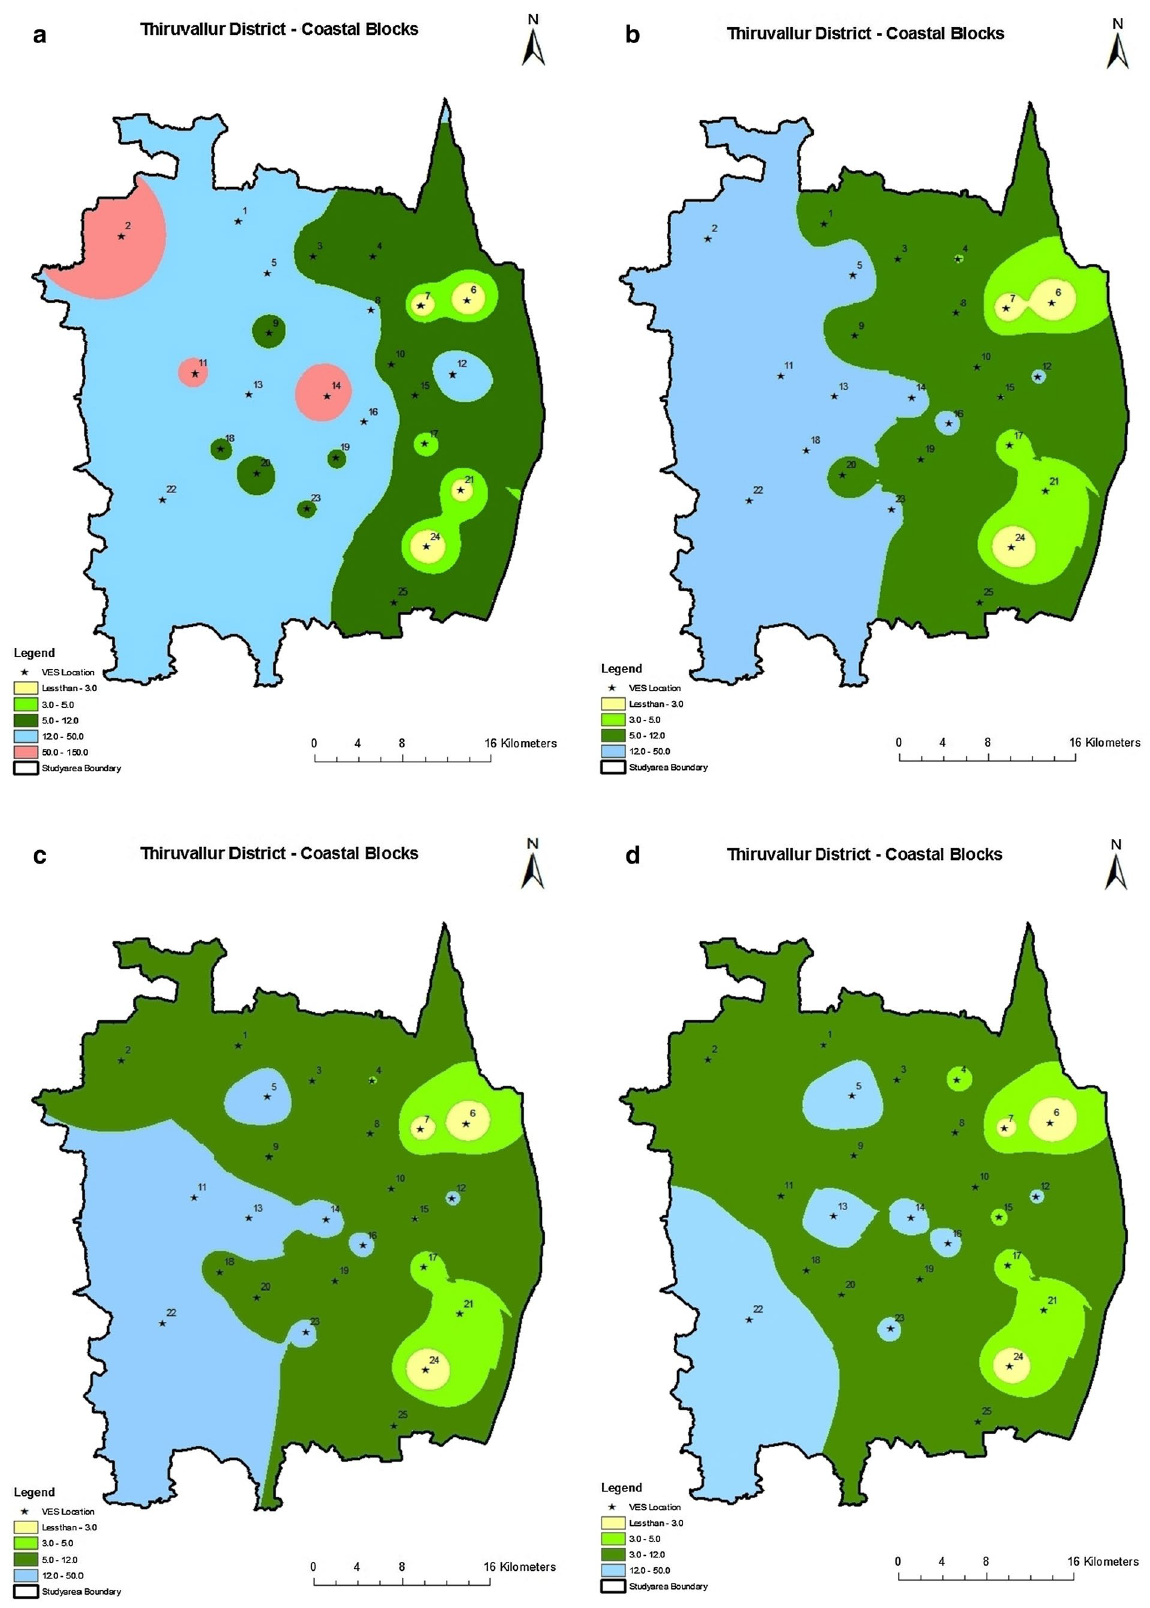
Fig. 12 Iso-apparent resistivity map at a 10 m, b 20 m, c 30 m, d 40 m, e 50 m